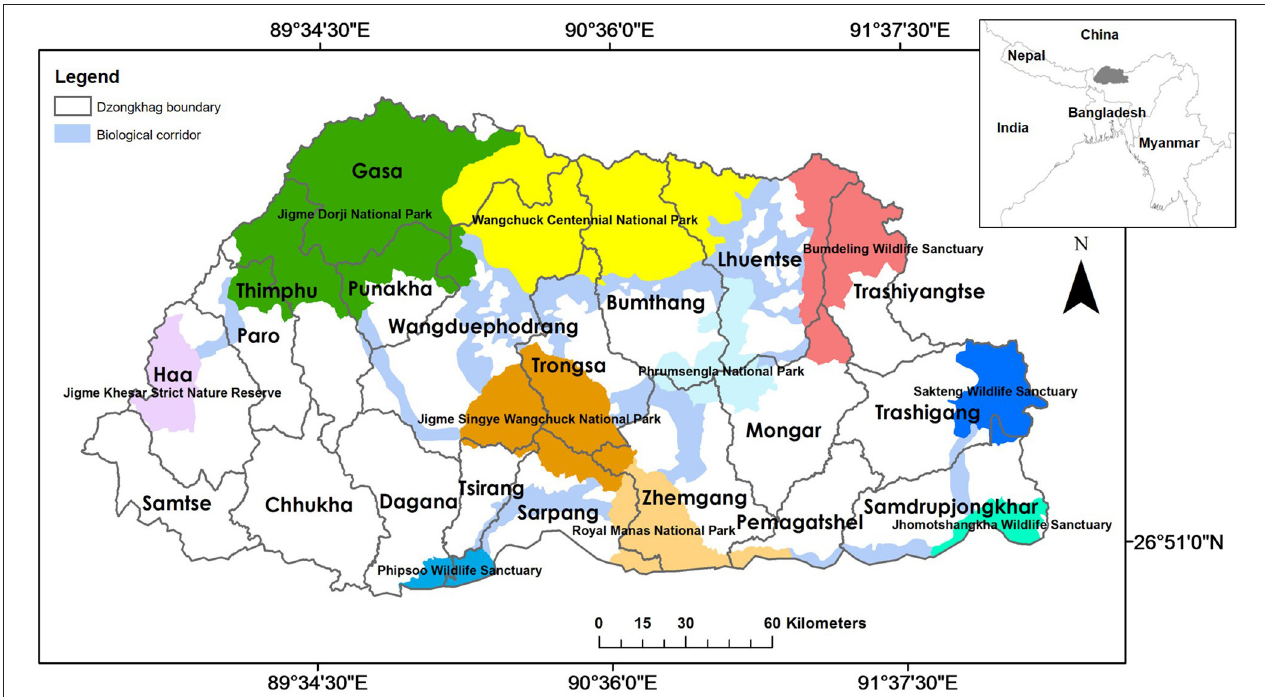
FIGURE 1 | Protected areas, biological corridors, and dzongkhags (districts) of Bhutan. The inset depicts Bhutan’s location relative to its neighboring countries in South Asia. Source: Environmental Systems Research,